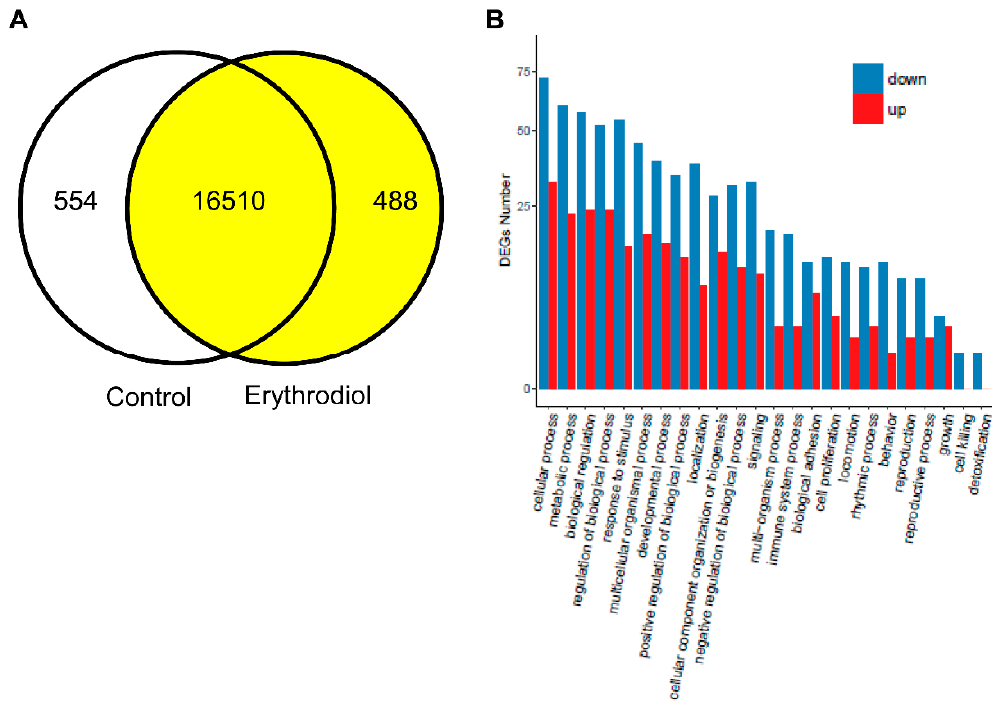
Figure 3. Di ff erentially expressed genes. ( A ), Venn diagram analysis. Control expressed 17,064 genes, while erythrodiol expressed 16,998 genes. Functional enrichment analysis of di ff erentially expressed genes. ( B ), Gene ontology (GO) classification of biological processes of liver transcriptome by erythrodiol administration. X axis represents GO term. Y axis represents the amount of up / down-regulated genes. DEGs, di ff erentially expressed genes.